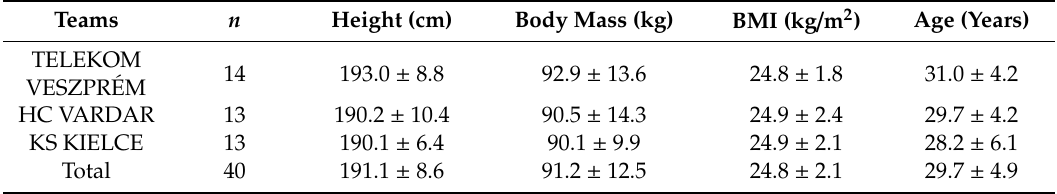
Table 1. Physical characteristics of the players (Mean ± Standard